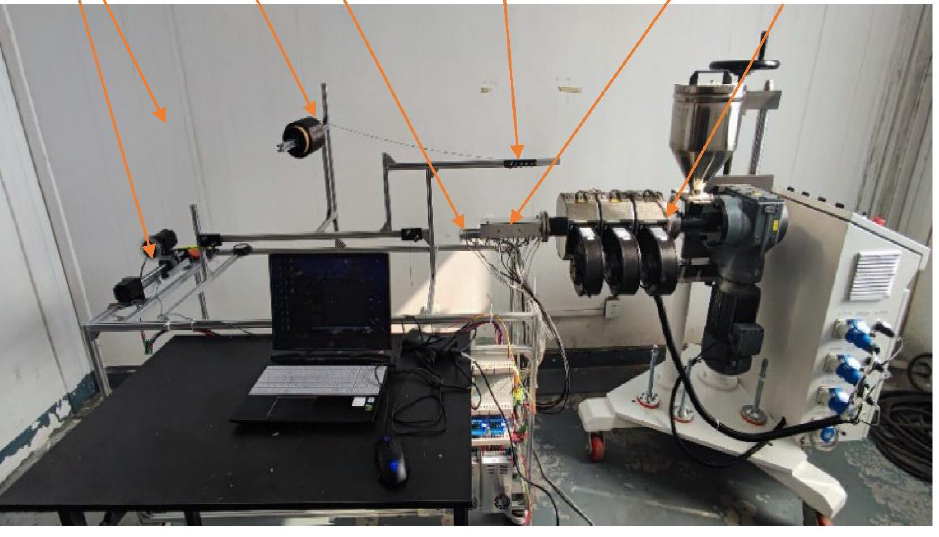
Figure 2. Equipment to prepare CFRPF.